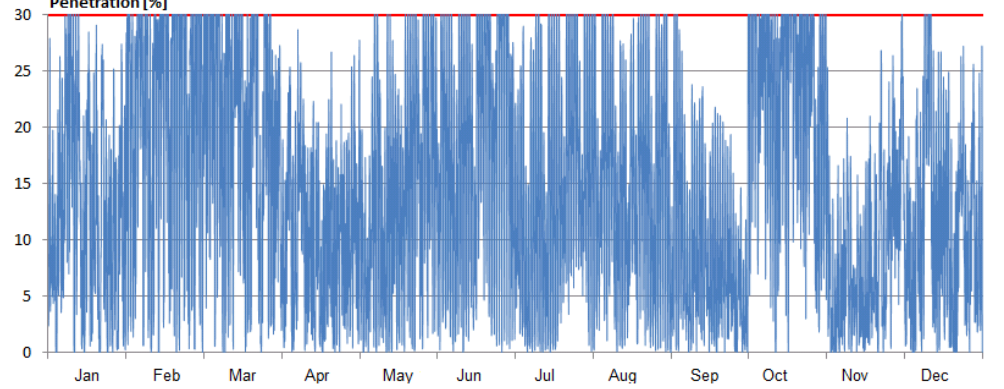
Figure 9. The penetration of RES following the optimized mini-hydro